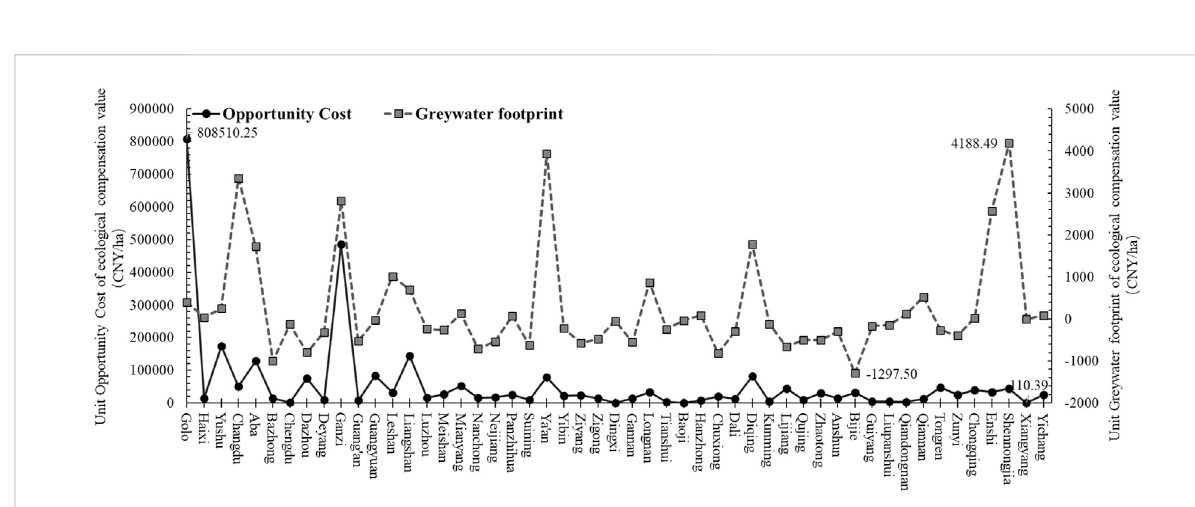
FIGURE 10 Comparison of opportunity cost and grey water footprint in the upper Yangtze